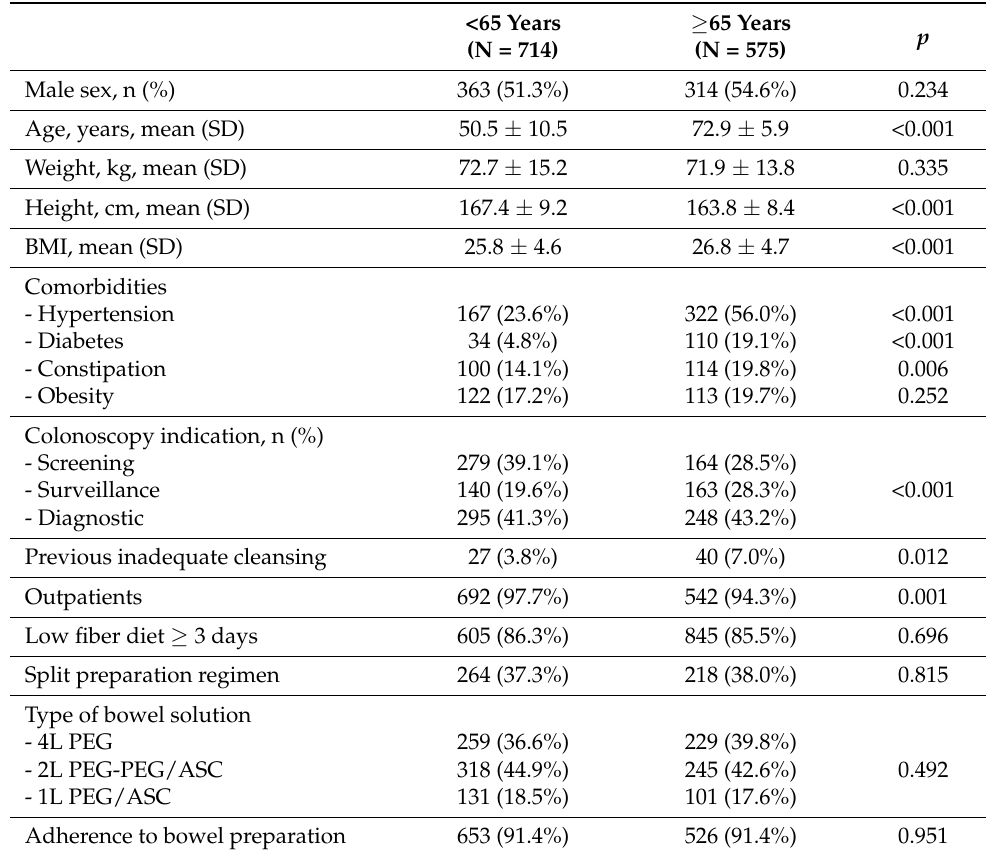
Table 1. Baseline patients’